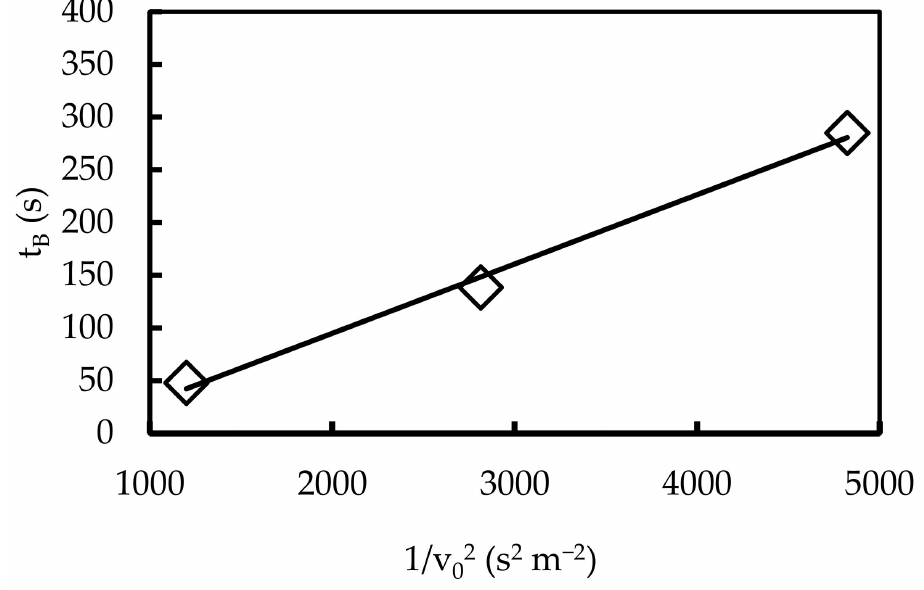
Figure 5. t B vs. 1/ v 02 for the solution containing M-PVAC-IDA using HGM separator (HGF-10 1). t B : Breakthrough time. v 0 : Fluid